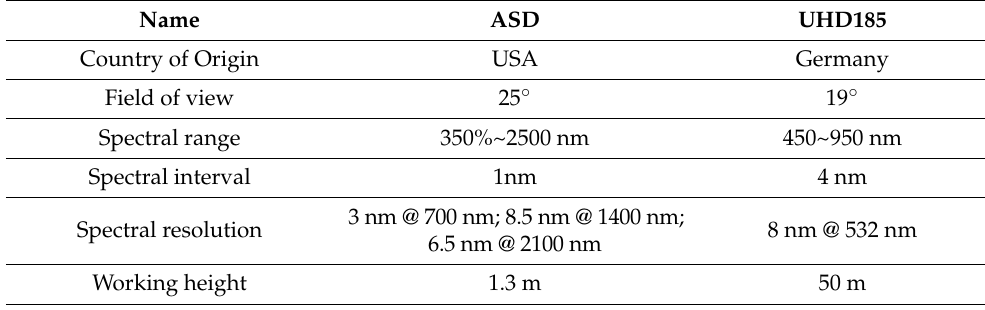
Table 1. Parameters of the sensors used for the collection of near-surface hyperspectral data and UAV hyperspectral